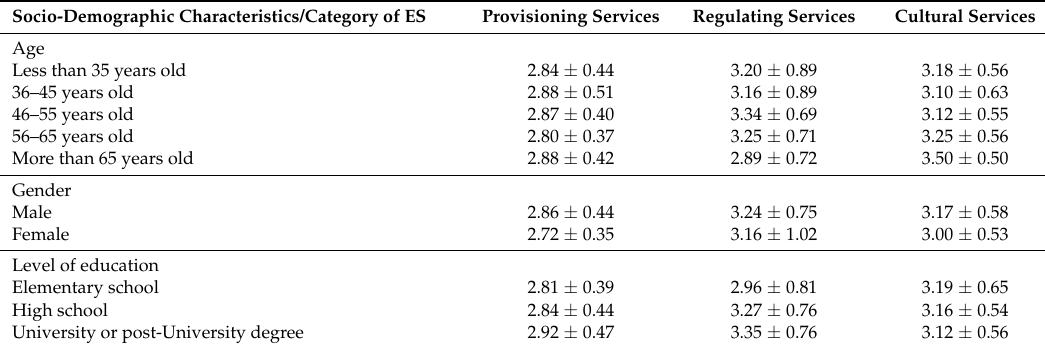
Table 6. Stakeholders’ preferences for categories of ES by socio-demographic characteristics of respondents (mean